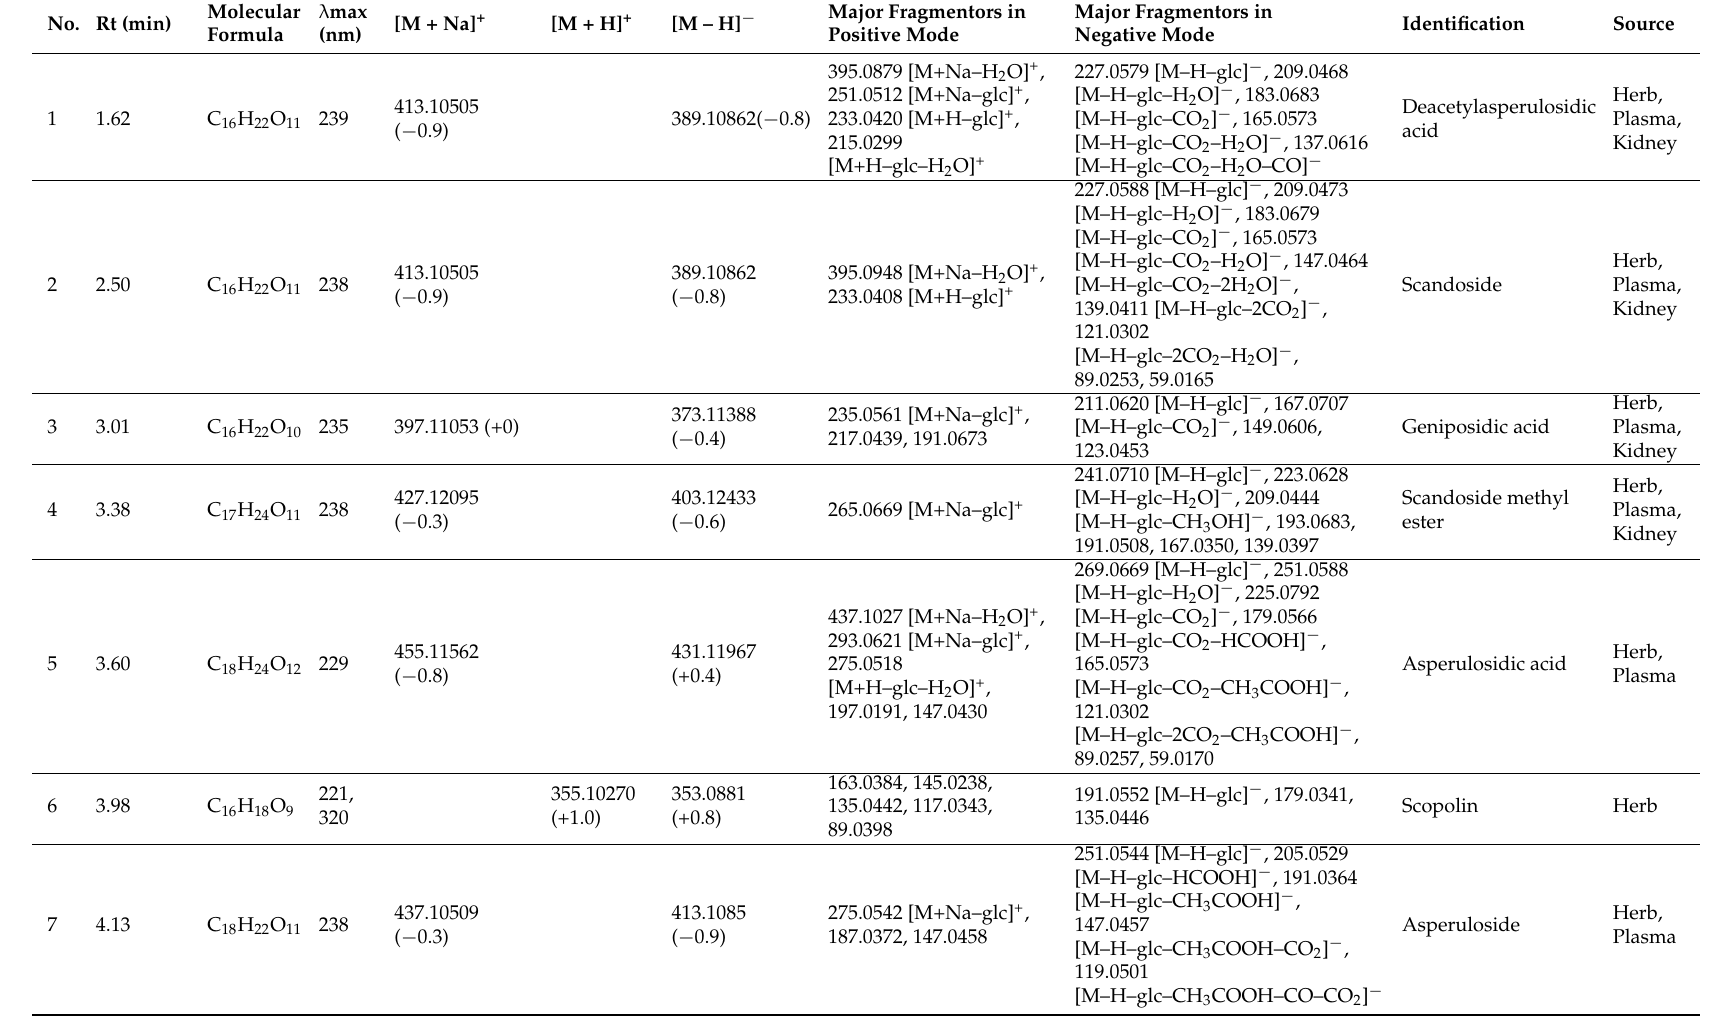
Table 1. Chemical profiles in H diffusa by ultra-fast liquid chromatography-diode array detector-quadrupole-time of flight mass